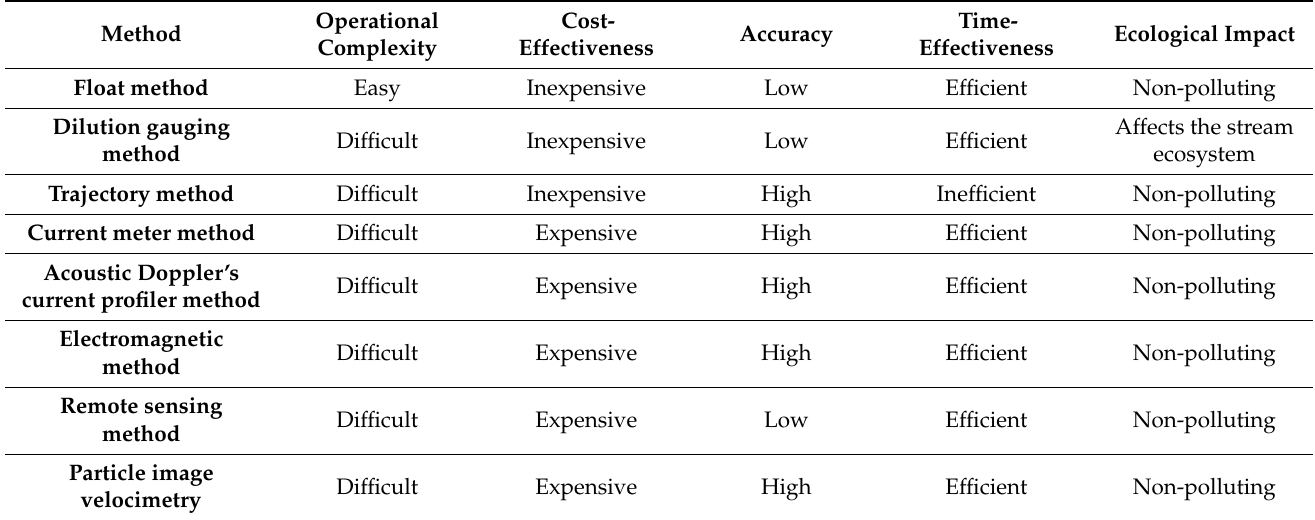
Table 1. Velocity estimation methods and their characteristics